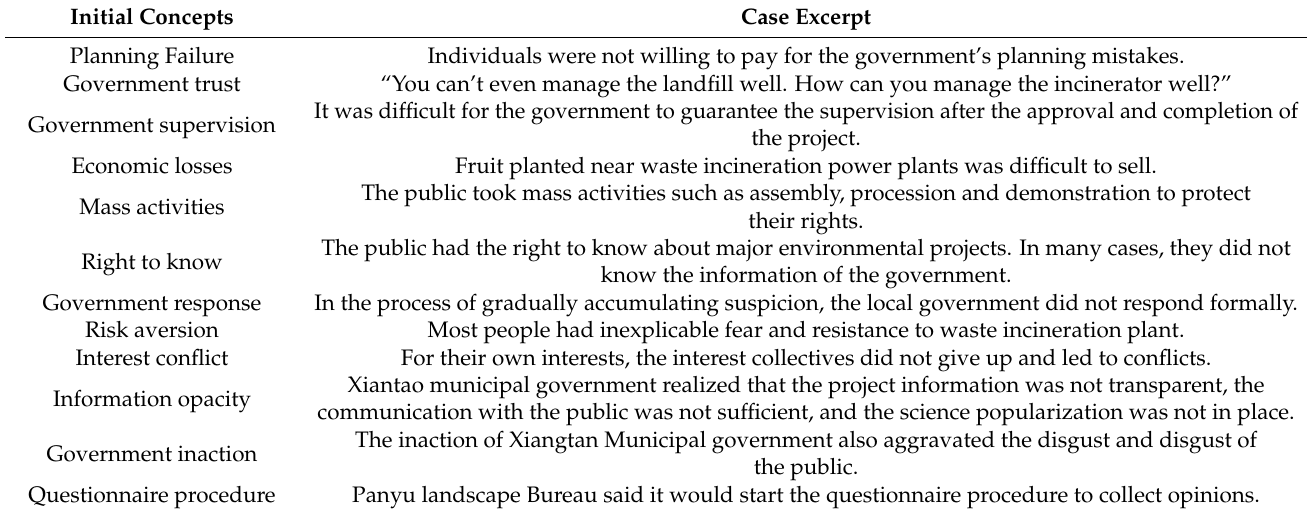
Table 1. Open coding of waste NIMBY crisis